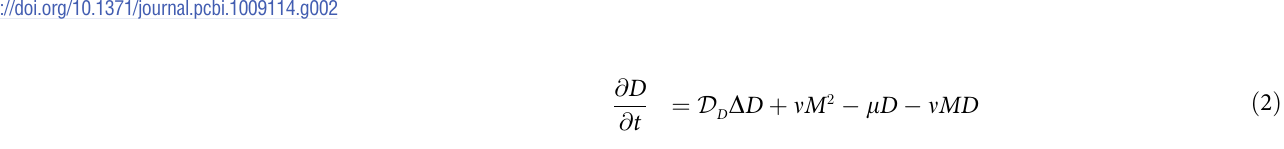
Fig 2. Means of obtaining model parameters. Some parameters (blue) were taken from published values in the literature; others (yellow-orange) were fitted based on experimental data; the value γ (green) is fitted from our overall model with reference to clinical data.